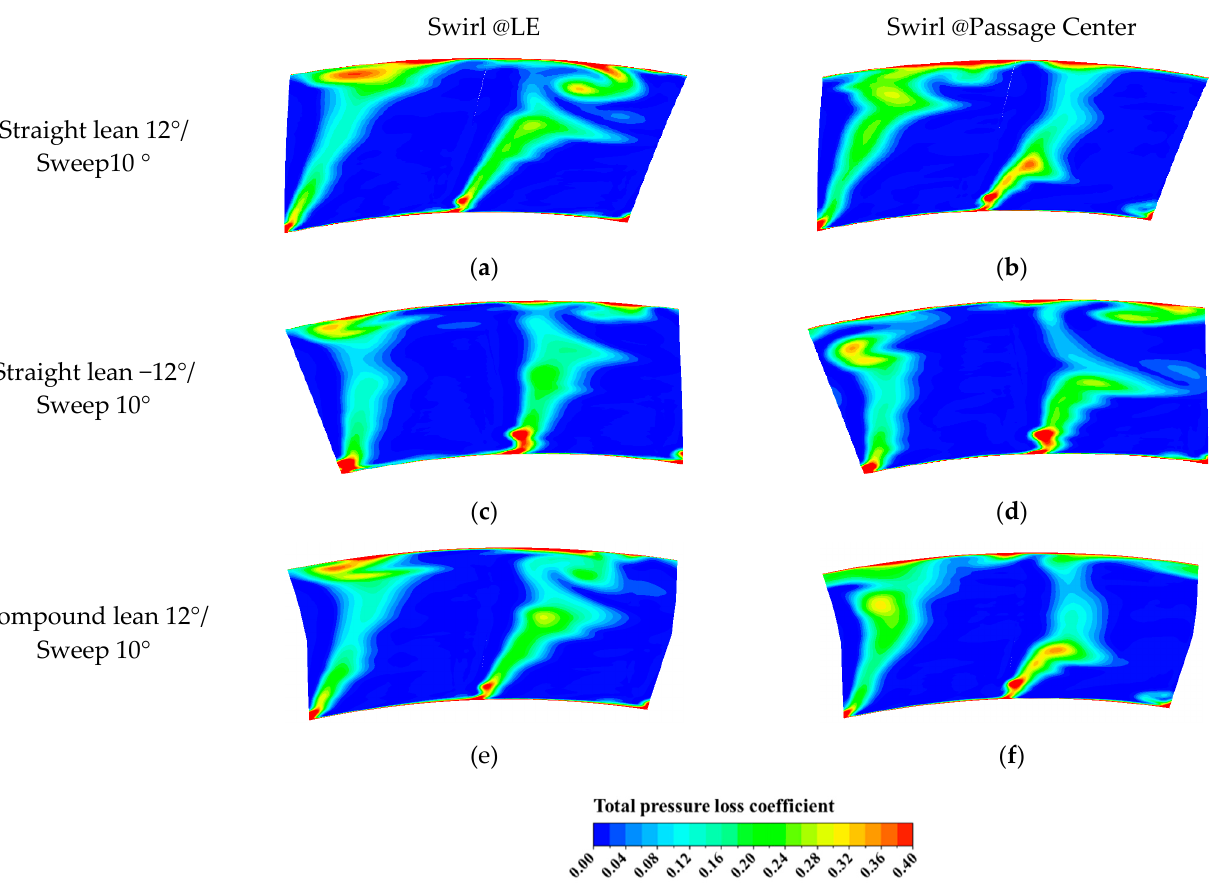
Figure 26. Total pressure loss coefficient at vane exit, z/C ax =1.06 (rear view): ( a ) SL12 SP10 SW@LE; ( b ) SL12 SP10 SW@PC;